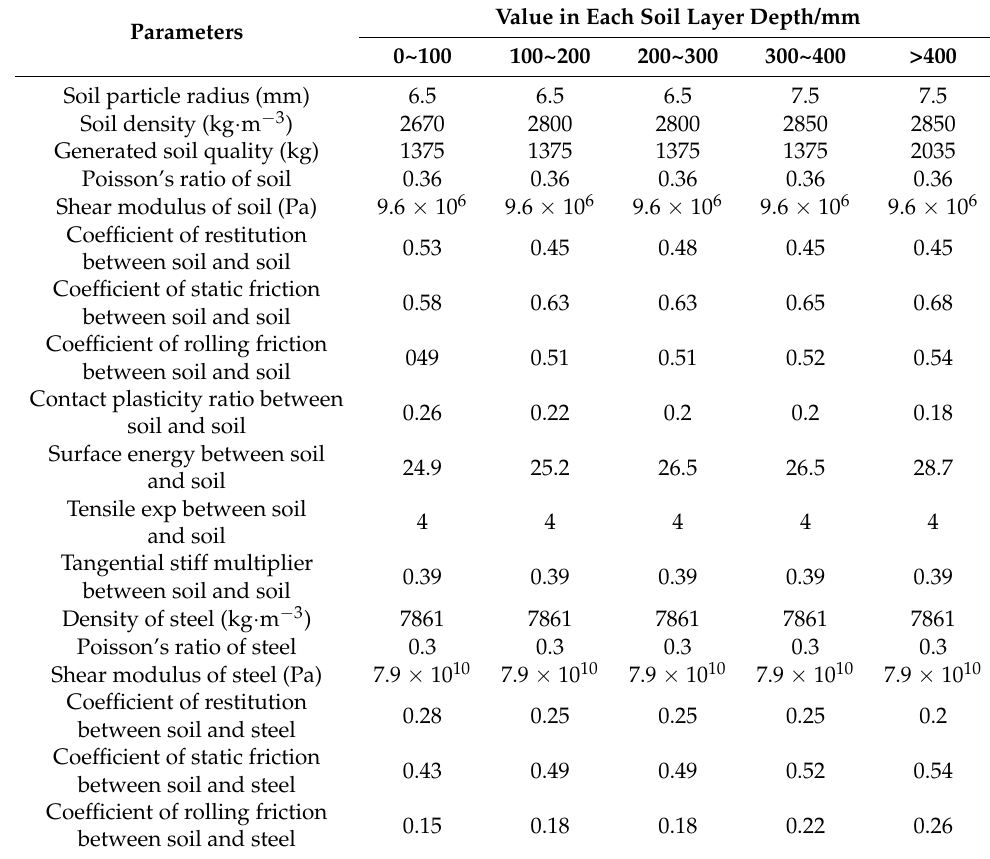
Table 1. DEM parameters and material properties used in DEM model of the liquorice